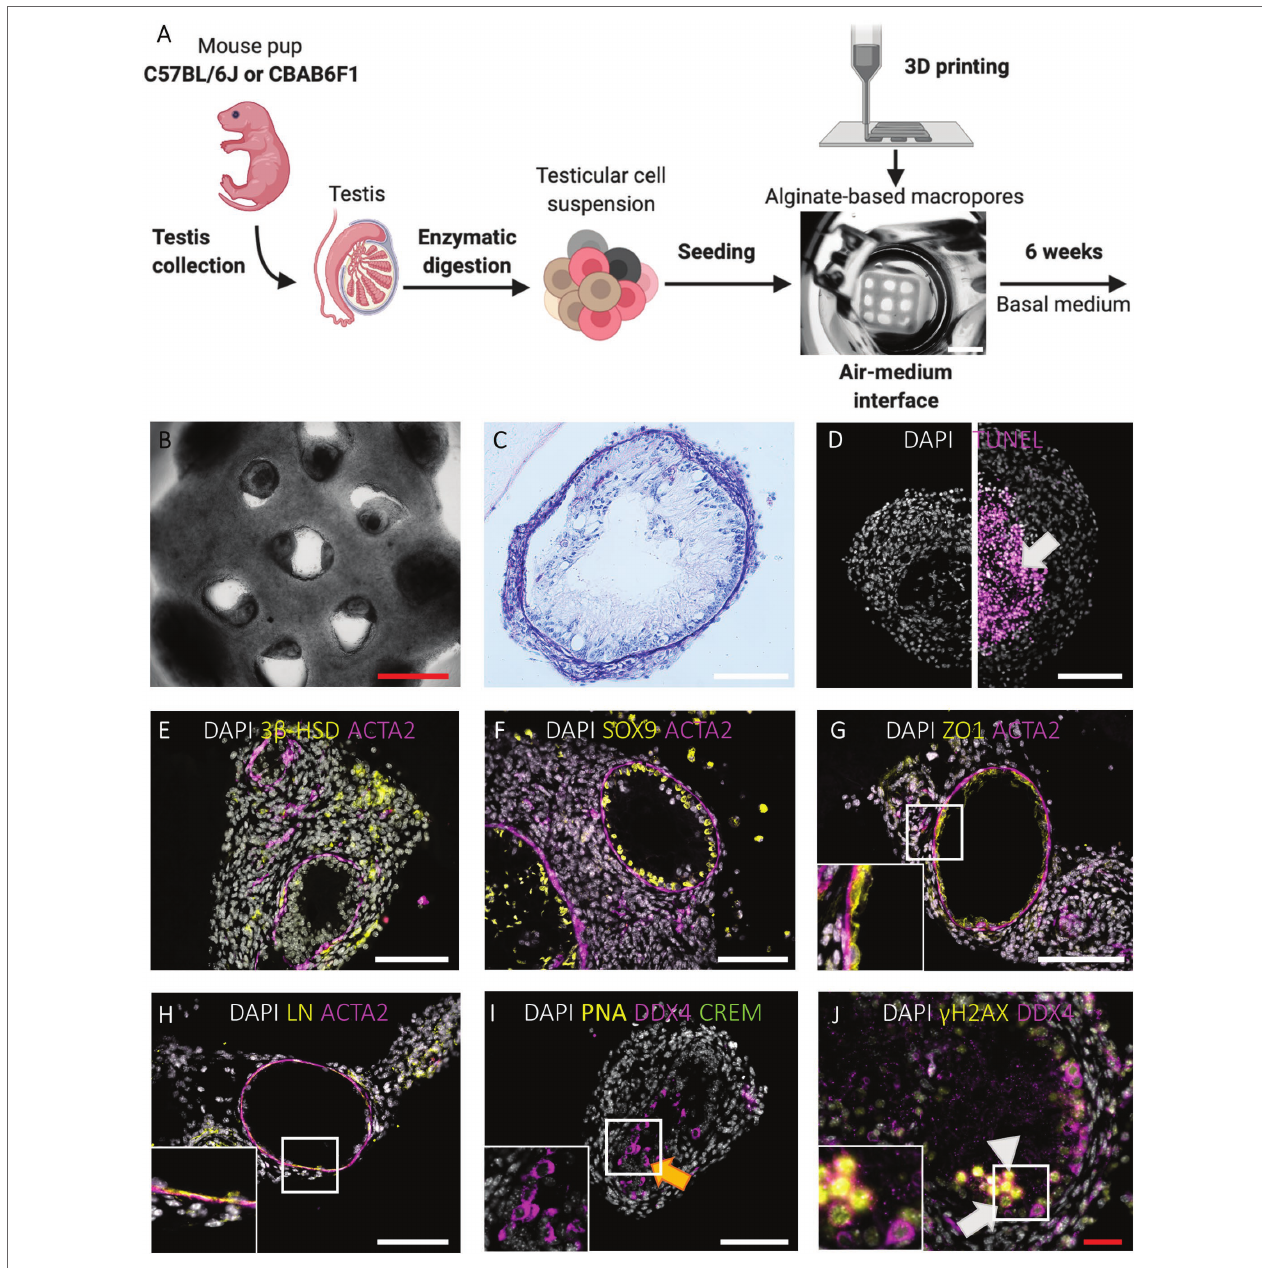
FIGURE 2 | Primary TOs in 1LS of both mouse strains restore in vivo testicular histology and support long-term survival and meiotic entry of early germ cells but display heterogeneous morphology. (A) Schematic representation of experimental procedure. Bar = 2 mm. (B-C) Gross morphological analysis of constructed TOs by bright field appearance (B) and PAS/Hematoxylin staining (C) . Bars = 500 µm (red) and 100 µm (white). (D) TUNEL assay revealed cell death in the central tissue region when early aggregates overgrew the macropores of 1LS to fuse into larger TOs (arrow). Bar = 100 µm. (E-H) Immunofluorescent staining of SSC niche cells and extracellular matrix: Leydig cells (3ß-HSD, E ), Sertoli cells (SOX9, F ), blood-testis-barrier (ZO1, G ), laminin (LN, H ), and peritubular myoid cells (ACTA2, E-H ) are shown. Inserts correspond to boxed areas (G-H) . Bars = 100 µm. (I,J) Immunofluorescent staining of TOs for the constitutive germ cell marker DDX4 (I-J) , the post-meiotic germ cell markers CREM and PNA (I) and the meiotic marker γ H2AX (J) . Orange arrow represents presumptive spermatocytes (I) . Boxed area includes leptotene (white triangle) and zygotene spermatocytes (white arrow) (J) . Bars = 100 µm (white) and 50 µm